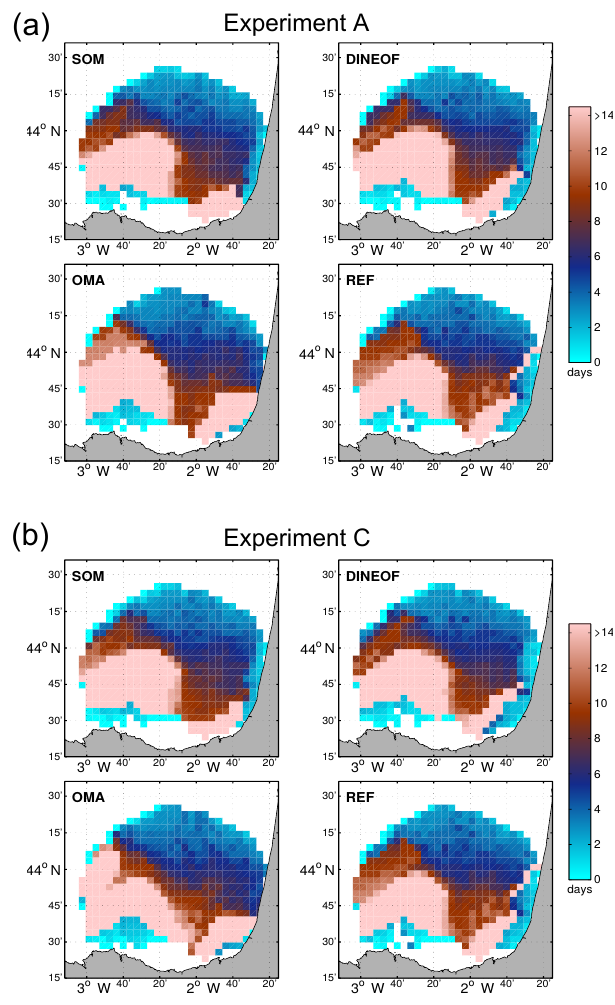
Figure 13. Snapshots of RT computed from the three filled veloc- ity fields and the reference HFR currents for experiments A and C corresponding to 4 April 2013, 18:00UTC.